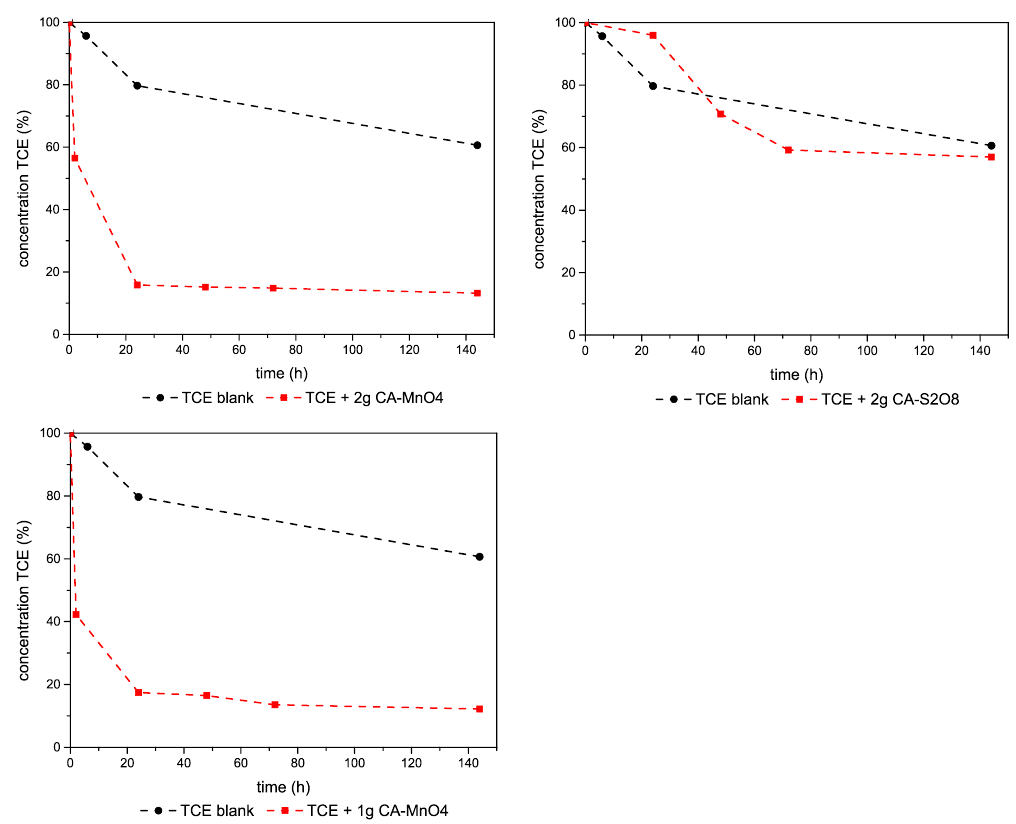
Figure 6. Results of the HS-PTV-GC-MS measurements with Ca,Al-LDHs using trichloroethene as the contaminant. Contaminant concentration (%) in solution over time (h). Blank solution as black dots, experimental solution as red squares.